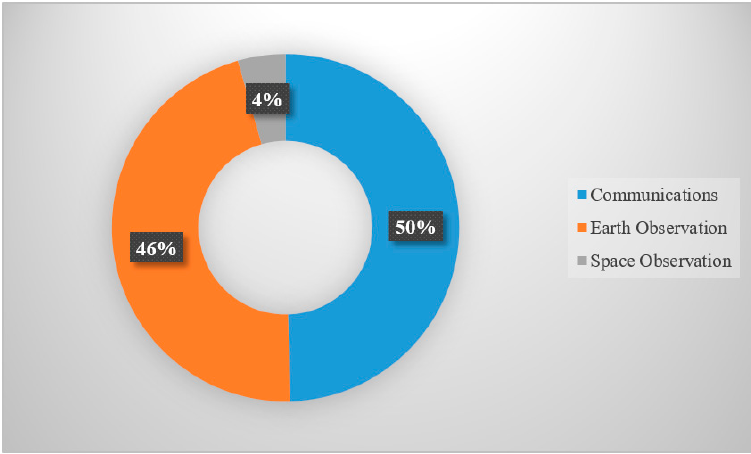
ff erent market fields.